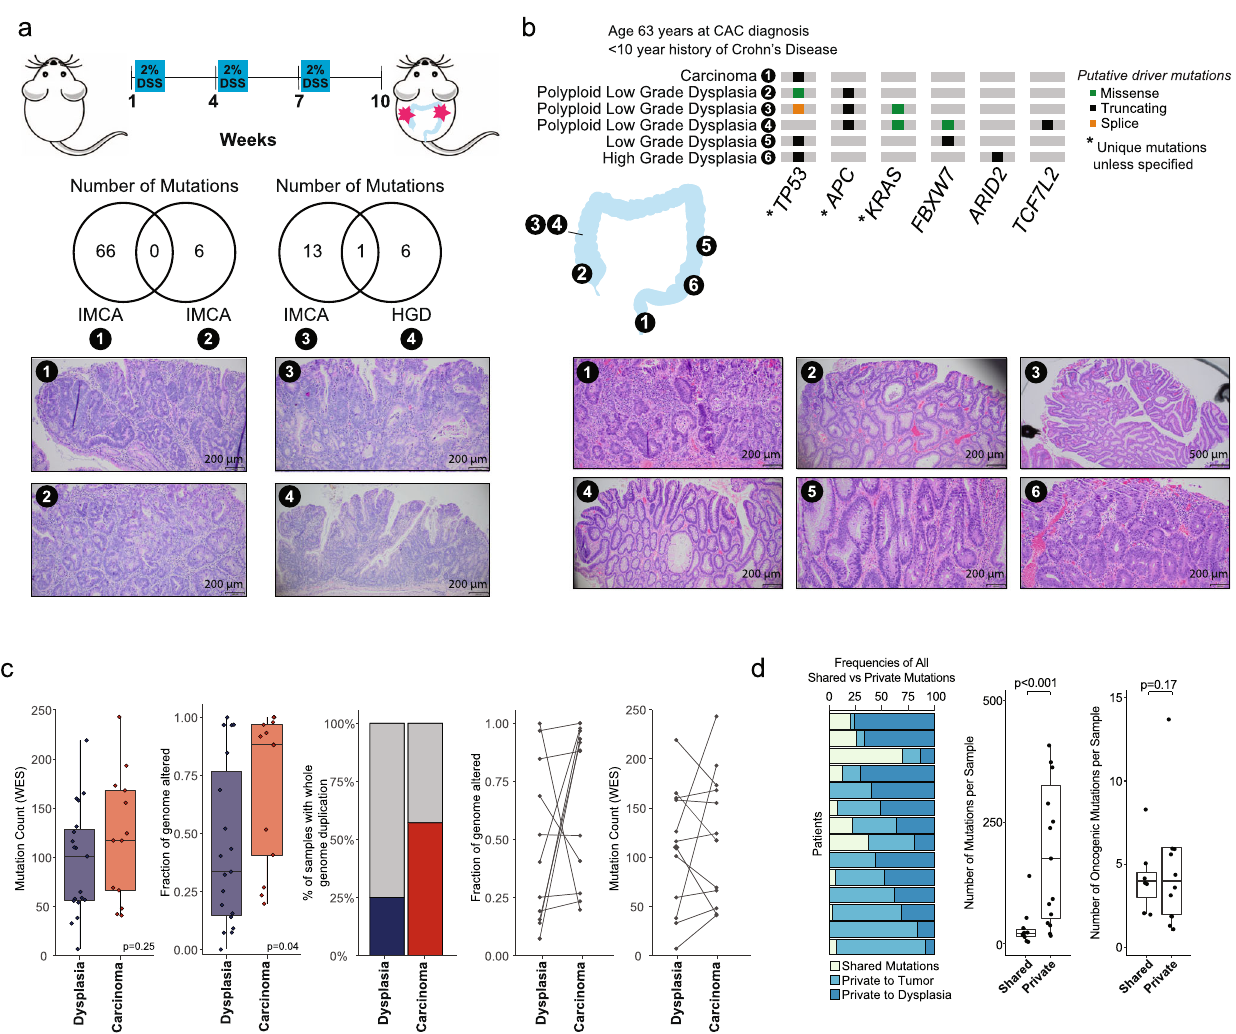
Fig. 4 | Genomic characteristics of dysplasia arising in in fl ammatory bowel disease. a Schema of AOM/DSS mouse model of in fl ammatory colon cancer, Venn diagram showing genomicalterationsidenti fi edin two separatelesions genotyped from each mouse, and Hematoxylin & eosin stained slides showing areas macro- dissected for DNA extraction for sequencing. Experiments were conducted ten times and two representative mice were chosen for genomic analysis. b Genomic analysis of dysplastic/cancerous areas identi fi ed in a colectomy specimen, with illustrations showing locations of samples analyzed, Hematoxylin & eosin stained slides of areas macrodissected for DNA extraction, and oncogenic genomic alterations identi fi ed in each sample ( fi ltered by OncoKB). Experiment was con- ducted one time. c Comparison of genomic changes detected by whole exome